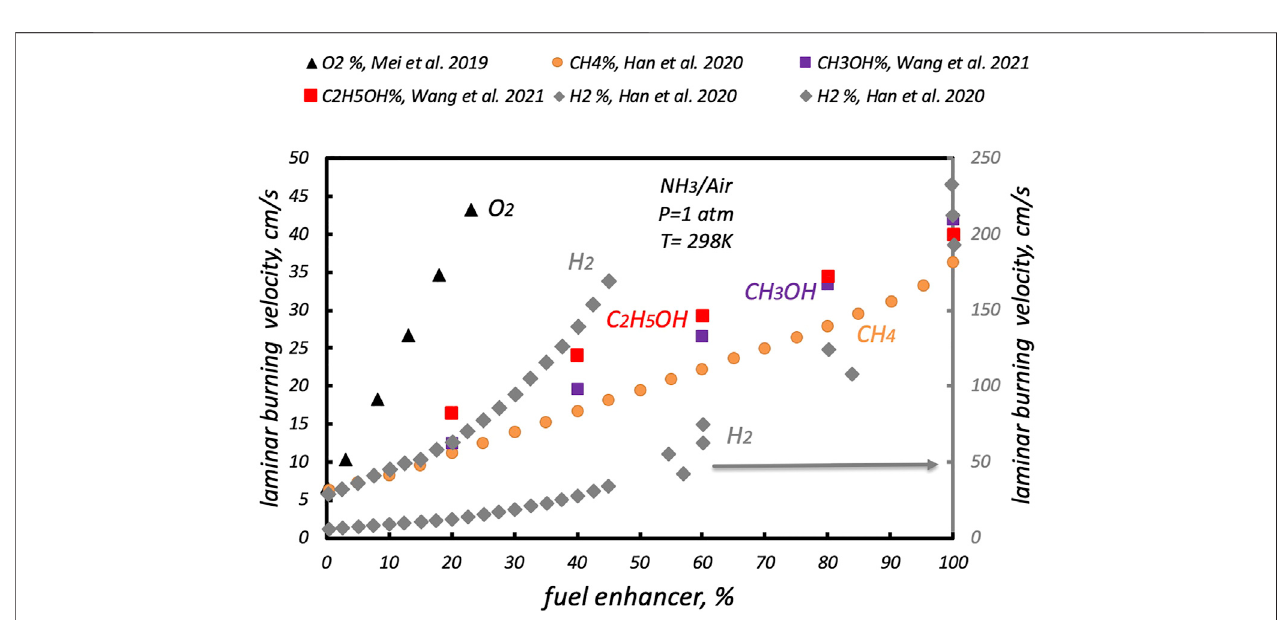
Frontiers in Mechanical Engineering |